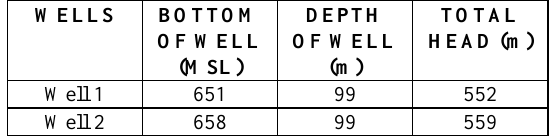
Table 6 Tube well (Reservoir) specifications